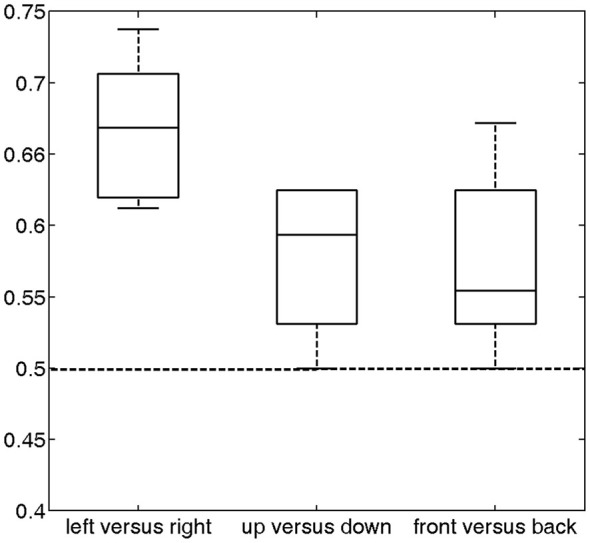
Classification accuracy across all subjects (median and distribution) for the three discrimination conditions (left vs. right, up vs. down and front vs. back). For these conditions, the average accuracies were 66.74% (p = 2.4 * 10−5), 57.81% (p = 0.0033) and 57.42% (p = 0.012), respectively, which were significantly higher than chance (50%, dashed horizontal line).